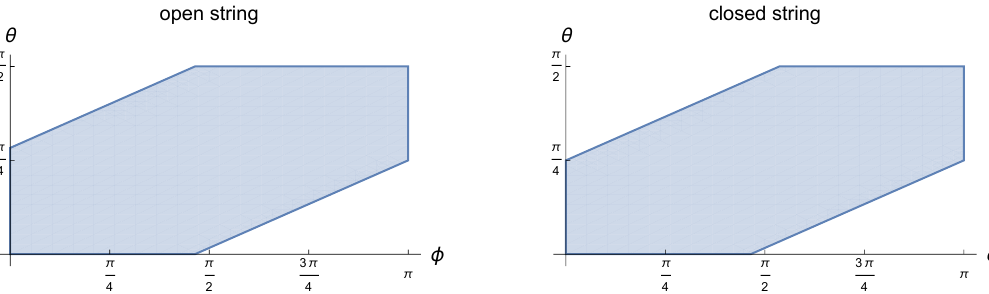
Figure 10: The convergence region Θ 12 ↔ 34 ( z ) of the open and closed string ampli- tudes for ε = 10 − 6